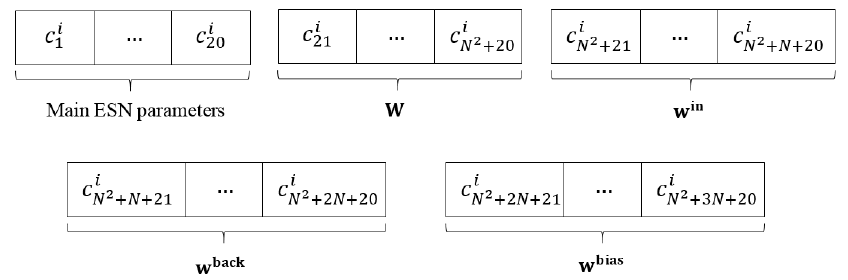
Figure 2. Conceptual division of c i . Adapted from Ferreira, Ludermir and Aquino